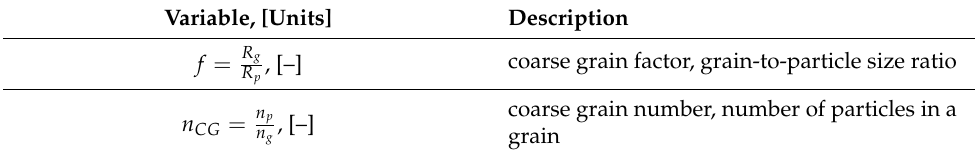
Table 1. Definitions of the coarse-graining